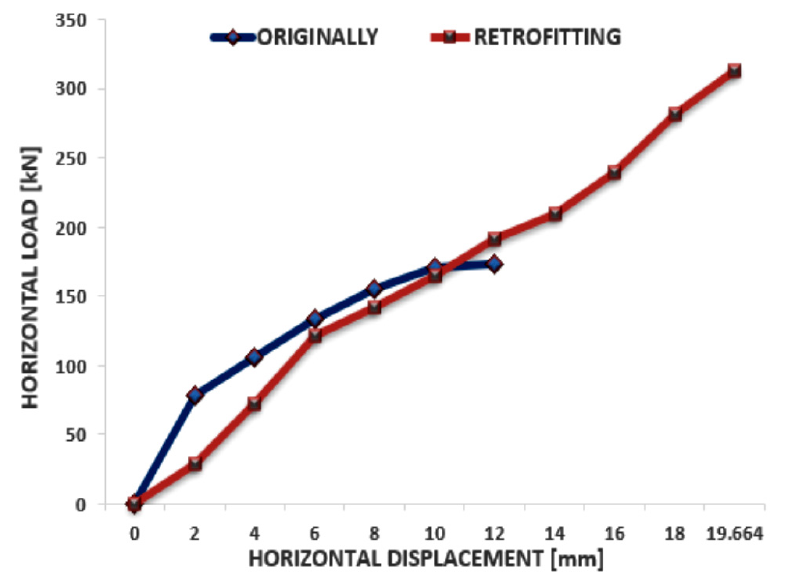
Figure 2. Graph load—displacement solid brick wall originally and retrofitting.